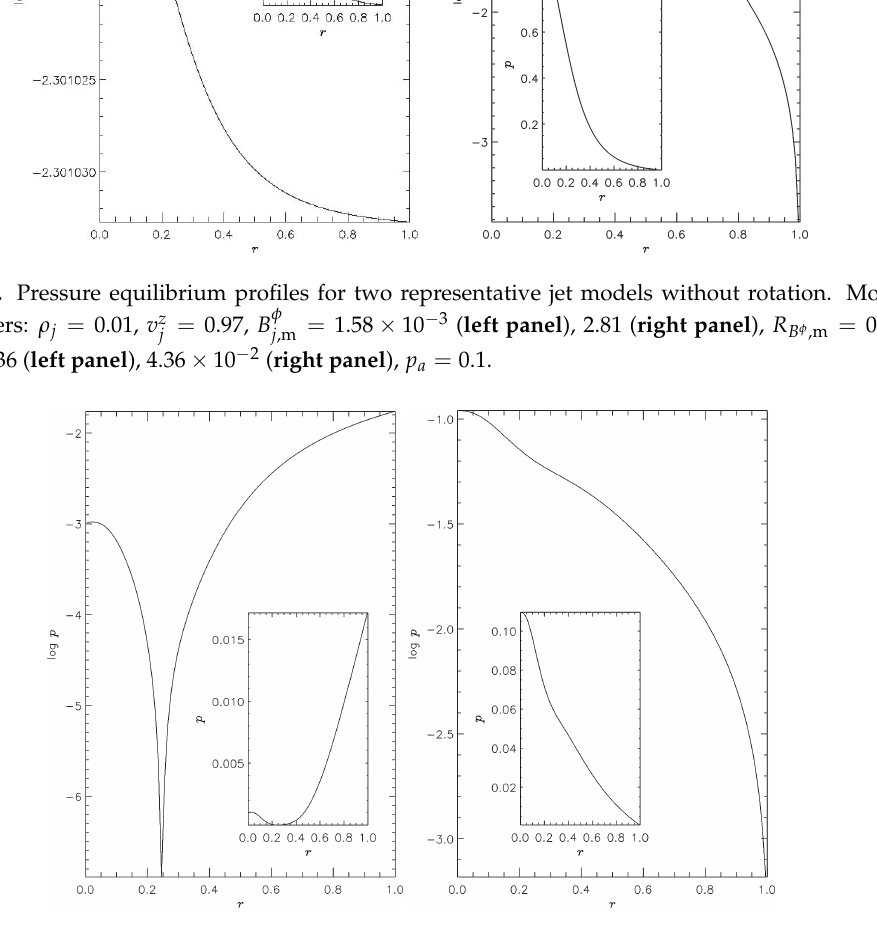
Figure 2. Pressure equilibrium profiles for two representative jet models with the same rotation profile (rigidly rotating inner jet core and a Keplerian sheath). Model parameters: ρ j = 0.01, v φ = 0.97, B φ = 0.151 ( left panel ), 0.443 ( right panel ), R R v φ ,m = 0.25, v z j j ,m ( left panel ), 4.41 × 10 − 1 ( right panel ), p a =